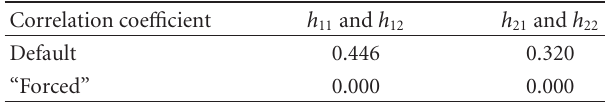
Table 5: Correlation coe ffi cient measurement for uncorrelated channel.